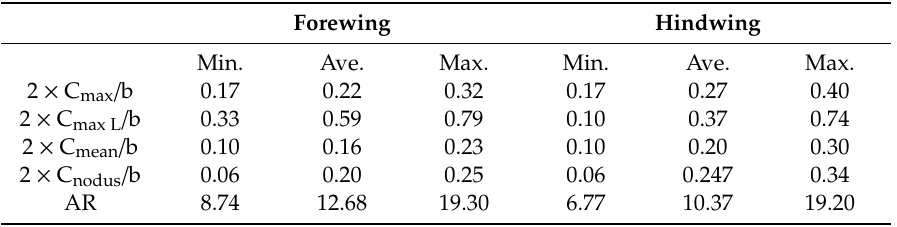
Table 3. Maximum, minimum, and average ratio for FW and HW.